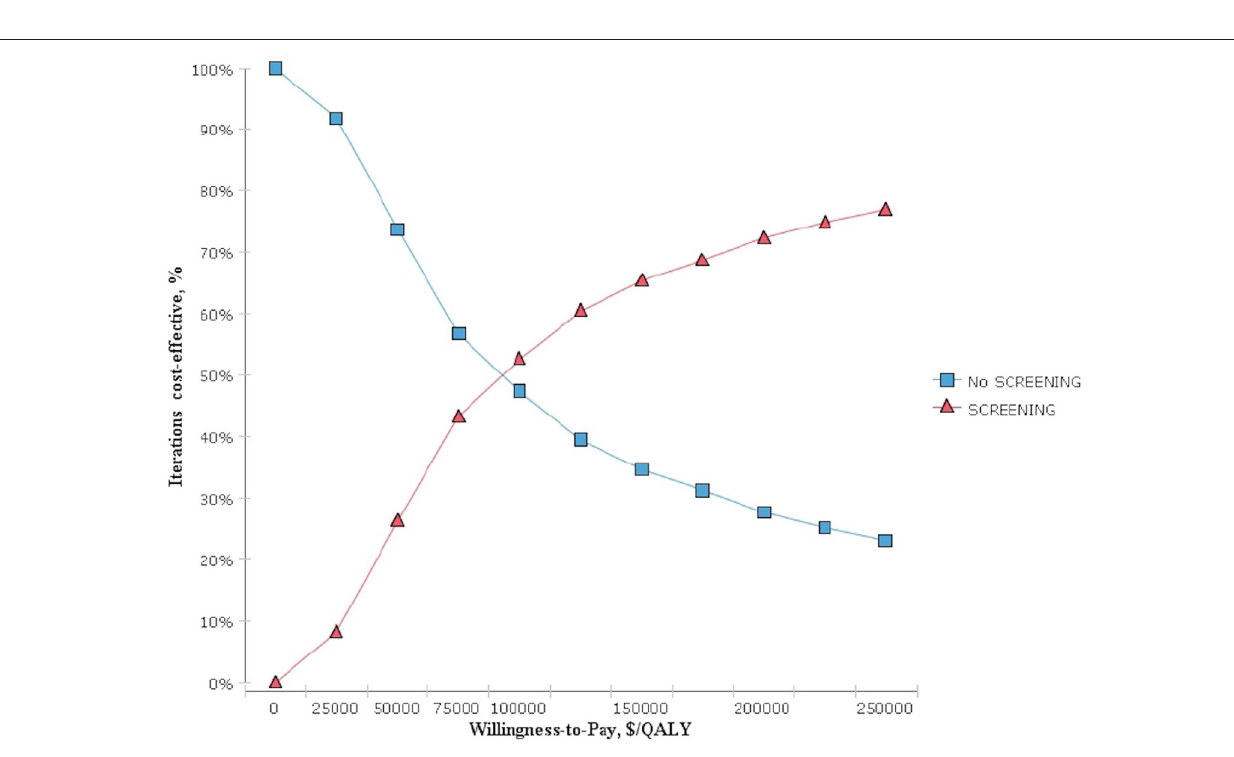
FIGURE 4 | Monte Carlo simulation cost-effectiveness acceptability